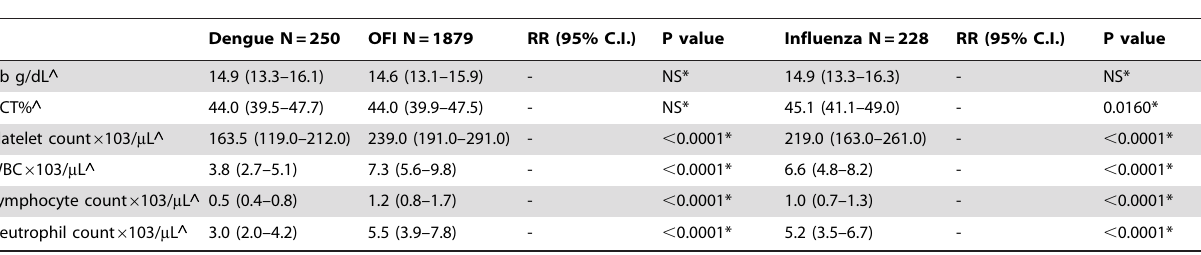
Table 4. The early laboratory parameters of dengue, OFI and influenza infection.